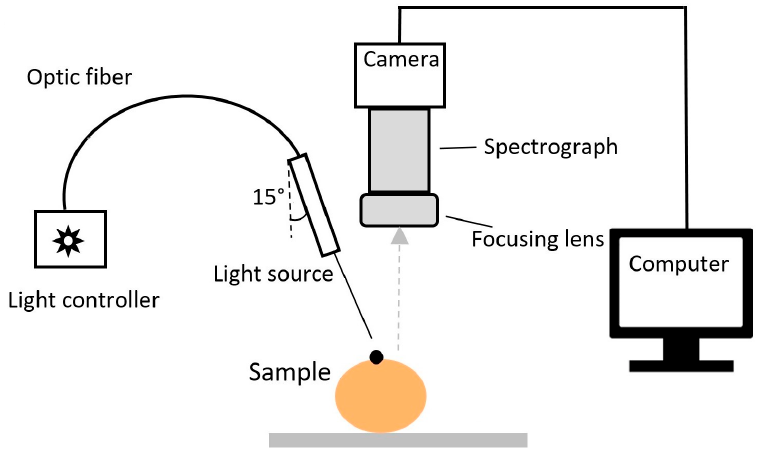
Figure 2. The scheme of a spatially-resolved spectroscopic system for measuring the optical properties of peach samples.